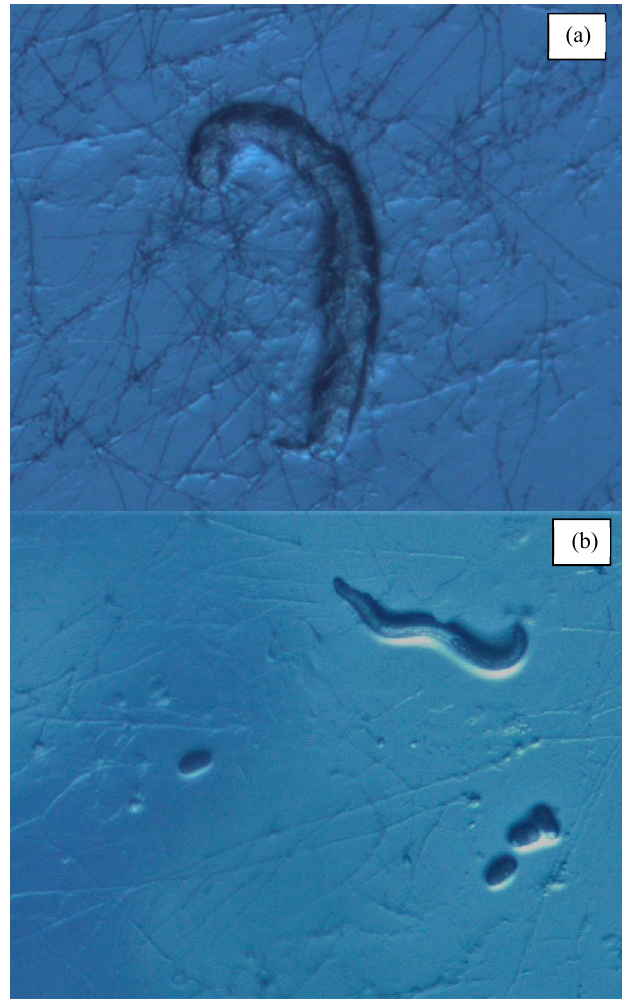
Figure 2. ( a ) Susceptible rhabditid species ( Poikilolaimus oxycercus ) being consumed by Pleurotus ostreatus hyphae. ( b ) Resistant cephalobid species, Zeldia punctata , interacting with Pleurotus ostreatus hyphae. Reproductive capability evidenced by the presence of eggs.